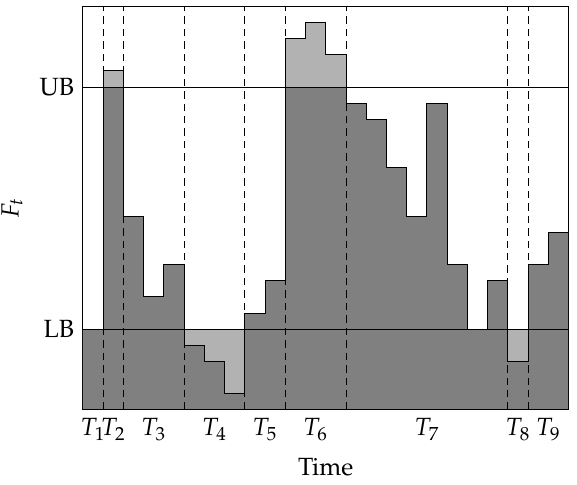
Figure 3. An example of the partition of the time intervals into blocks T 1 , T 2 , . . . , T 9 for the given values of F t . The upper and lower bound are marked by the horizontal lines. Light grey areas indicate how much the storage device has to charge or discharge to obtain a feasible flow. A light grey area above the upper bound indicates charging required, while a light grey area below the lower bound indicates discharging required. The vertical dashed lines indicate where a new block